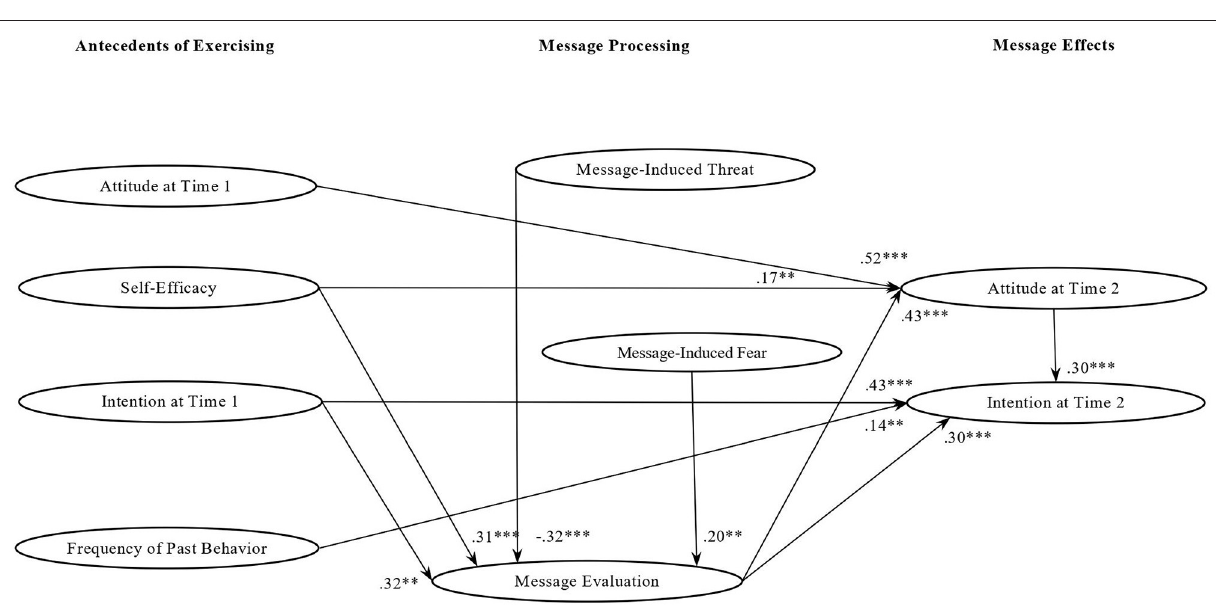
analysis ( Ind. = 0.03; p = 0.10). In turn, a higher level of intention at Time 1 influenced intention at Time 2 ( β = 0.83; p = 0.001), but it also increased message-induced fear ( β